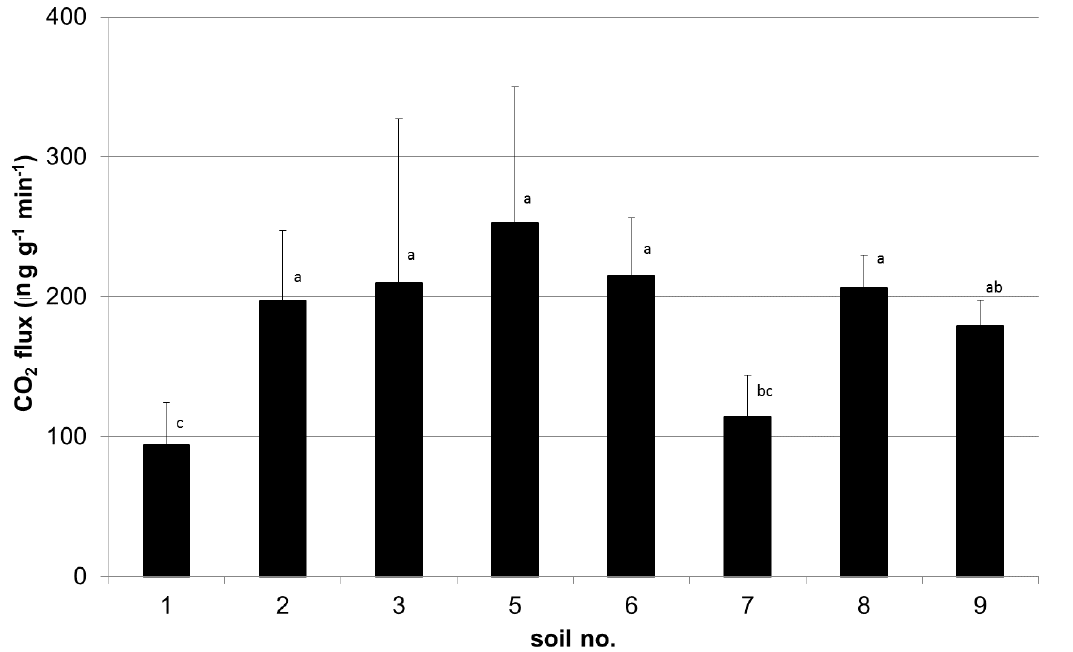
Figure 3. Carbon dioxide emission rates (ng g -1 min -1 , dry mass basis) from the eight peat topsoils (Sites 1– 3 and 5–9) at a suction head of 1.0 m water column ( n = 7). Different letters in the labels denote significantly different values (p < 0.05).